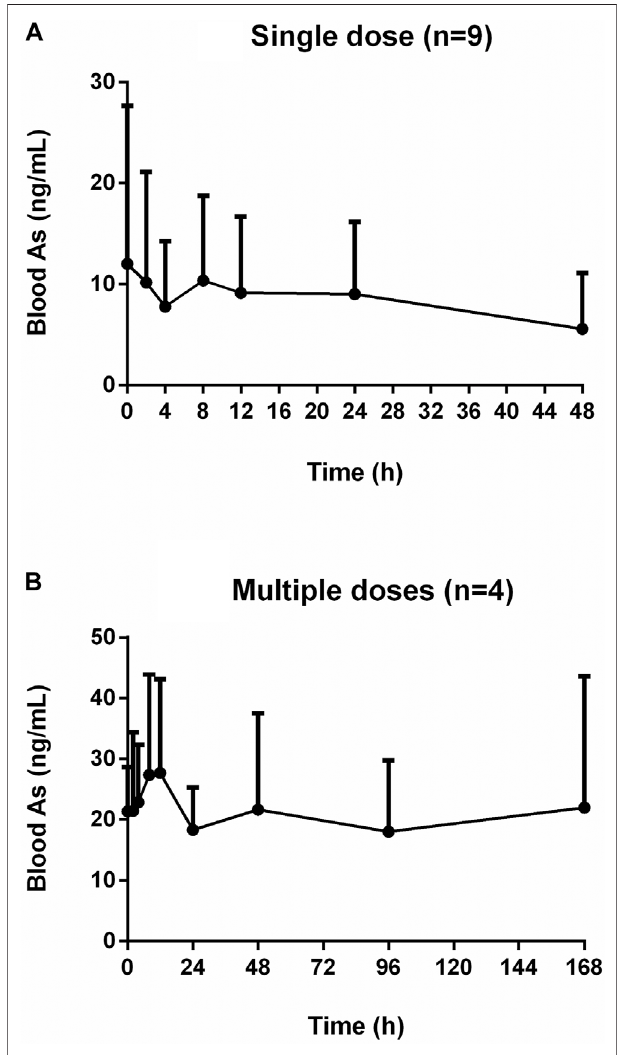
FIGURE 1 | Concentration-time pro fi les of human blood arsenic after oral administration of NHJDT. (A) . single dose ( n (cid:1) 9); (B) . multiple doses ( n (cid:1) 4).